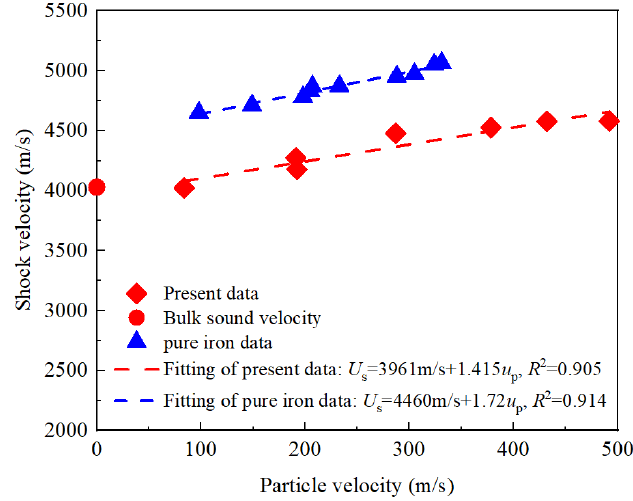
Figure 7. Shock velocity-particle velocity relationship for the HSLA, along with data for pure iron from Thomas et al. [10].